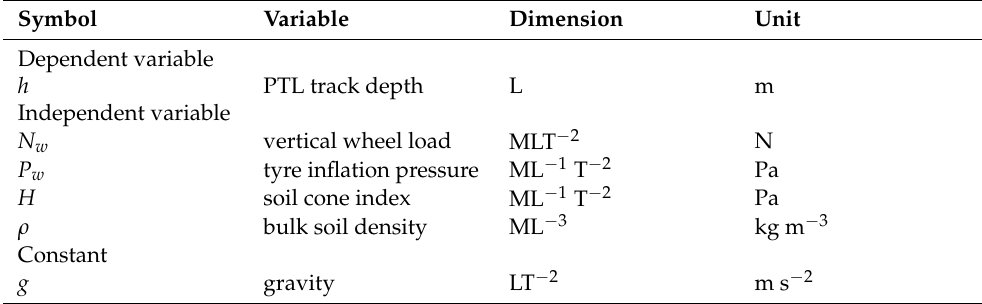
Table 1. Variable influencing the depth of